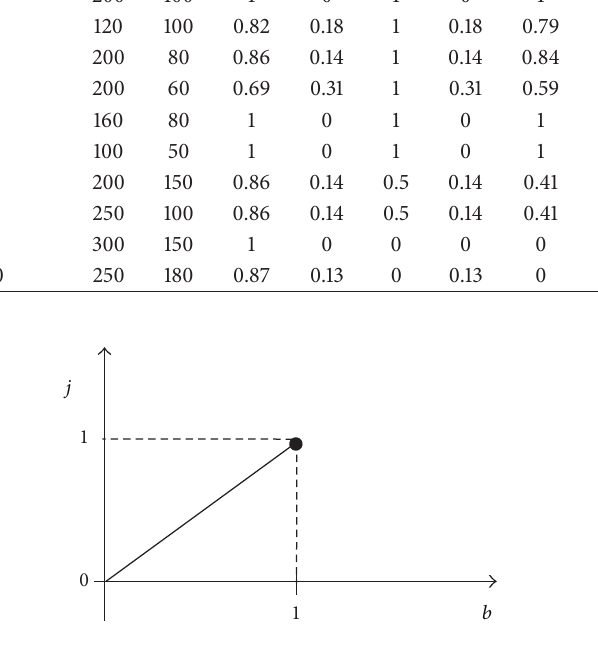
Figure 3: Function of the disharmony coefficient 𝑗